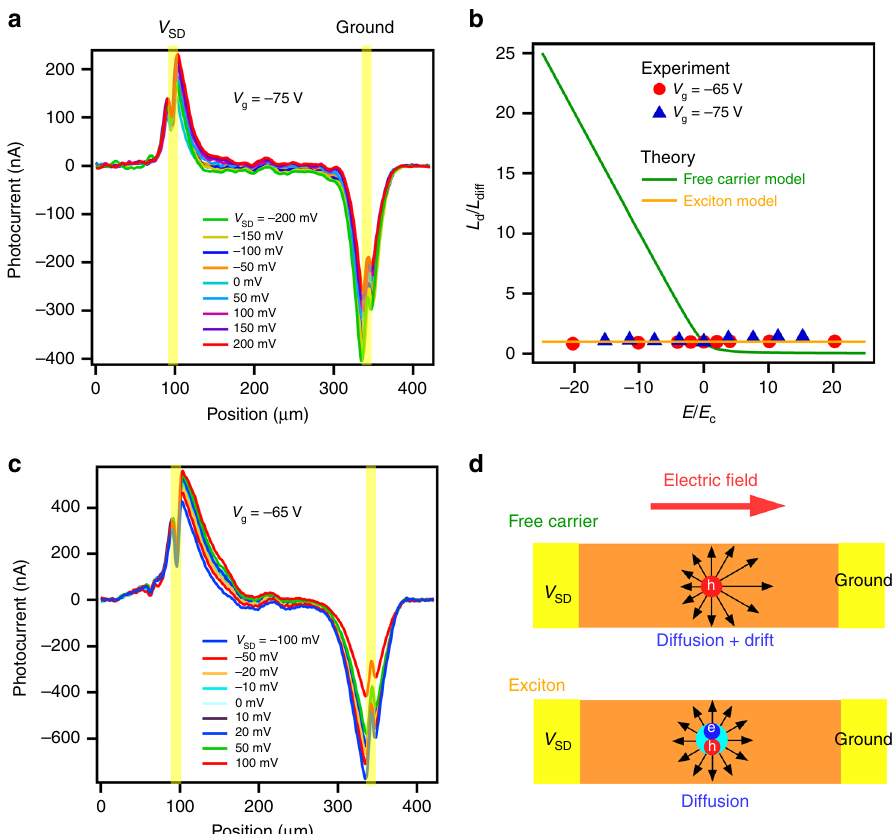
Fig. 2 Electric fi eld-independent photocurrent pro fi les at 7 K. The dark current induced by V SD is subtracted from the total current. A gate voltage is applied to shorten L d in order to observe possible electric fi eld induced changes. a , c Photocurrent as a function of laser excitation position along the nanoribbon axis at various V SD and V g = − 75 V ( L diff = 11.4 μ m) and − 65 V ( L diff = 30.1 μ m), respectively. Laser power is 20 μ W. Vertical yellow lines indicate the contacts. b L d near the left electrode extracted from a , c as a function of electric fi eld E . L d is normalized by diffusion length L diff measured at V = 0 V. E is normalized by critical electric fi eld E SD c . Green and orange solid lines represent the photocurrent decay lengths predicted by the free carrier model 38 and exciton model, respectively. The fi eld-independent L d indicates carriers are bound into charge neutral excitons. d Schematic showing that motion of free carriers is affected by external electric fi eld, while excitons are